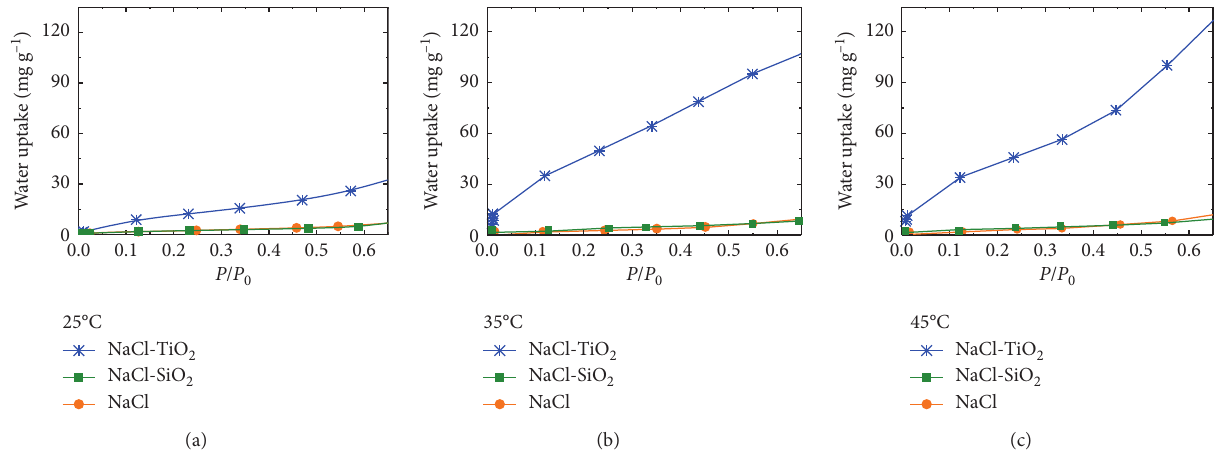
Figure 10: Comparison ofisotherms ofNaCl,NaCl-TiO